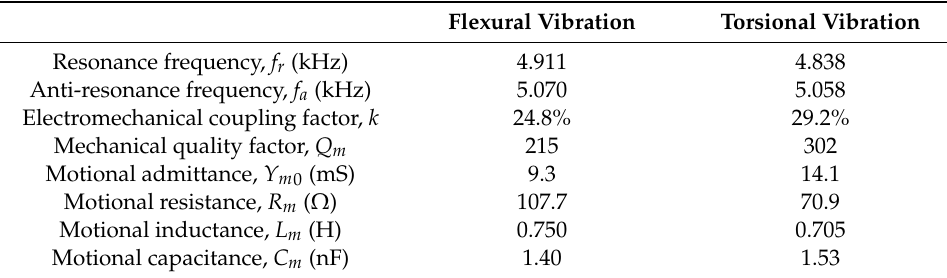
Table 2. Equivalent circuit parameters of the T / F vibrator.